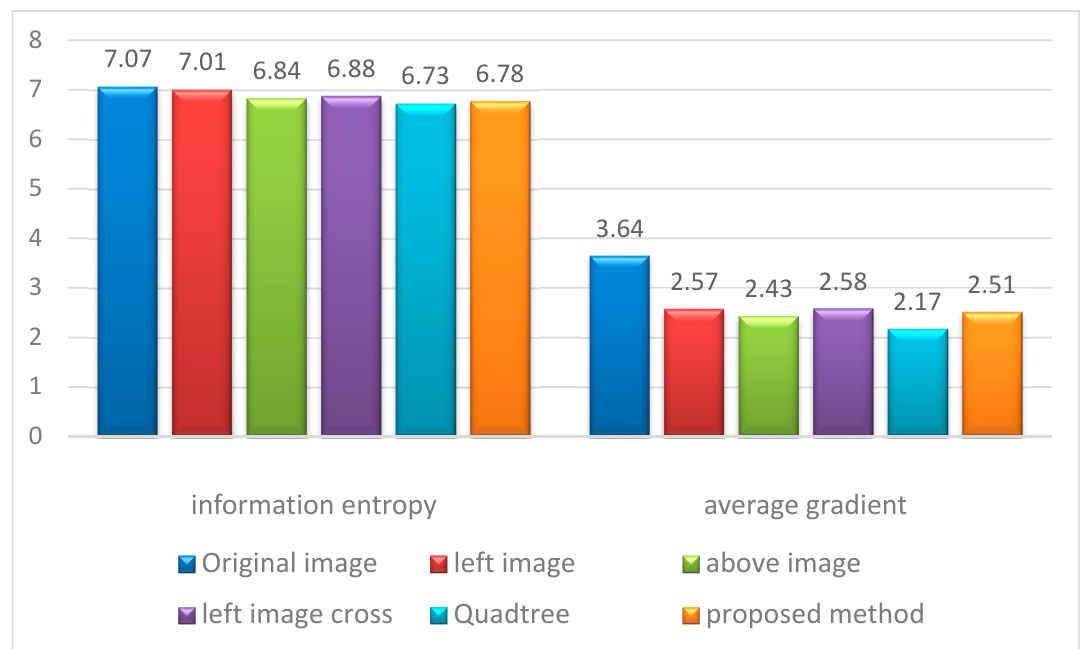
Figure 8. Average gradient and information entropy of the processed results of different methods.